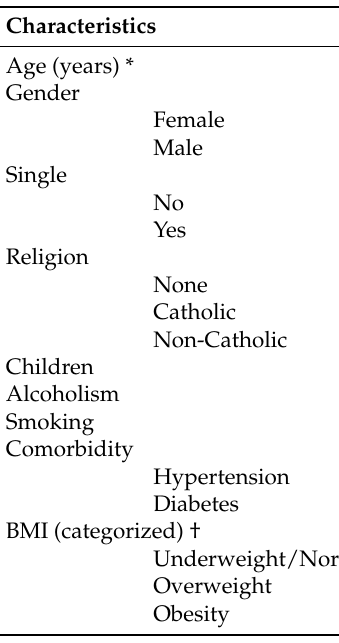
Table 1. Characteristics of participants ( n =